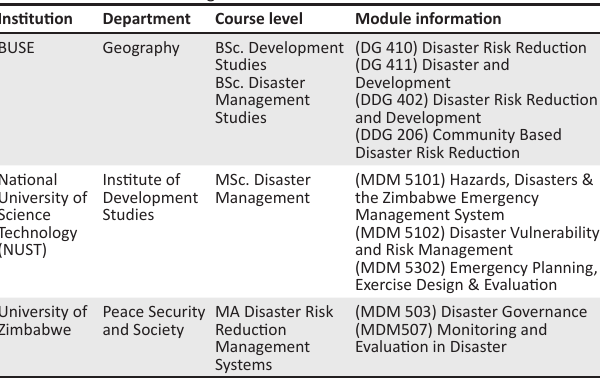
Table 1 indicates universities that have DRM programmes in Zimbabwe.